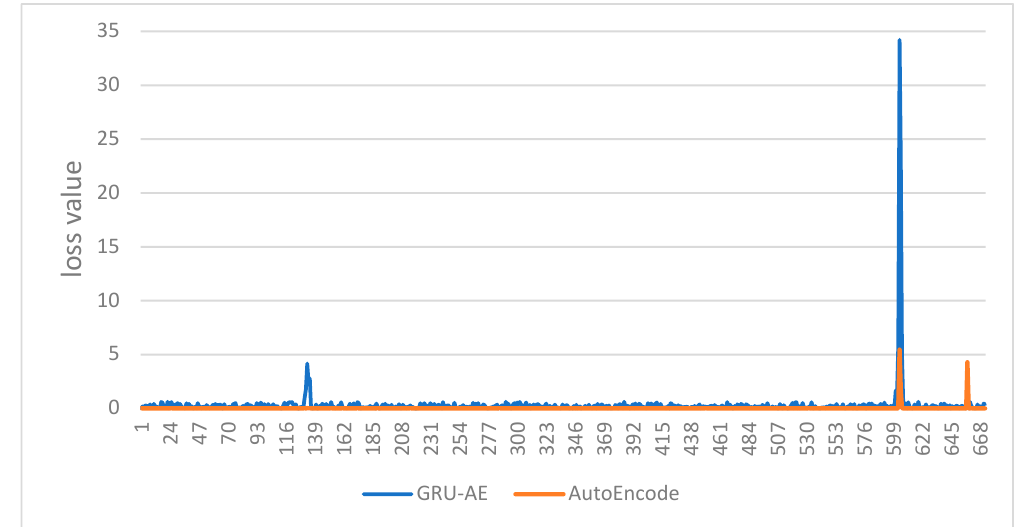
Figure 17. Comparison of the loss value changes of the two models in test set 2.